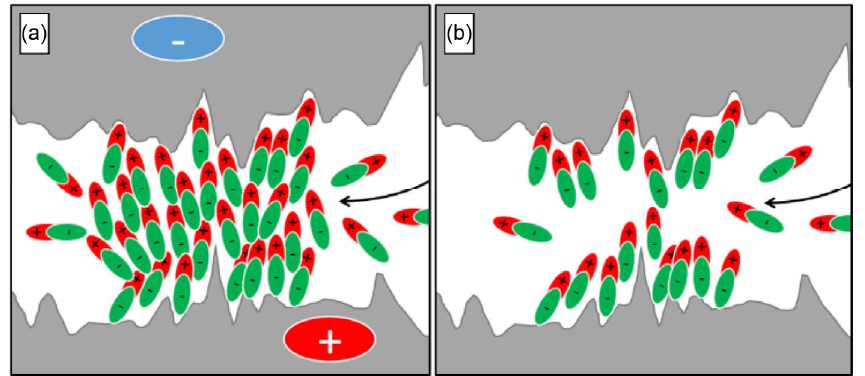
Fig. 8 Schematic of ionic liquid alkyl chain behaviour (a) during excitation and (b) after